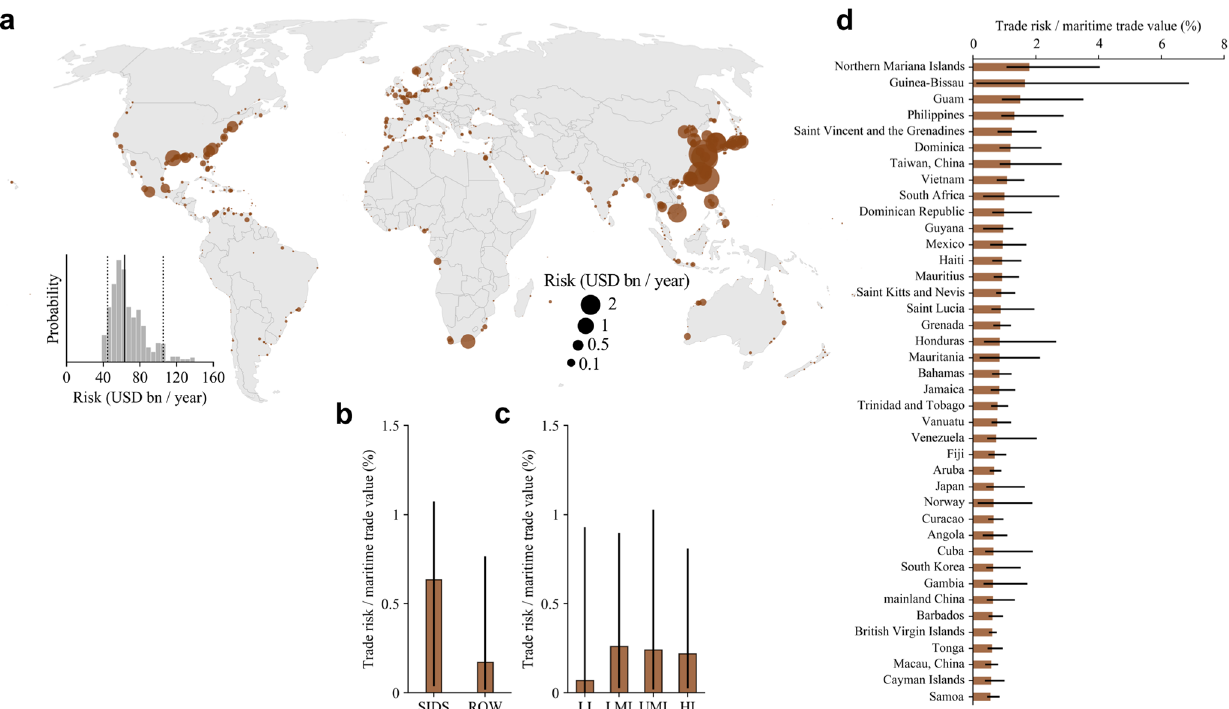
Fig. 3 Global footprint of trade risk. a The median trade risk is USD bn per year, re fl ecting the risk of trade disruptions as a result of downtime per port. The histogram illustrates the global aggregated trade risk across the 10,000 samples, with the black line indicating the median and the dashed lines indicating the 5th and 95th percentiles. b The distribution of the trade risk over Small Island Developing States (SIDS) and Rest of World (ROW) countries, with the bar showing the median across countries and the error bar at the 5 to 95th percentiles. c Same as ( b ) but for countries grouped by the different income groups. d The trade risk is expressed as a percentage of the annual maritime trade value. The top 40 economies are depicted with the error bar indicating the 5-95th uncertainty range across the 10,000